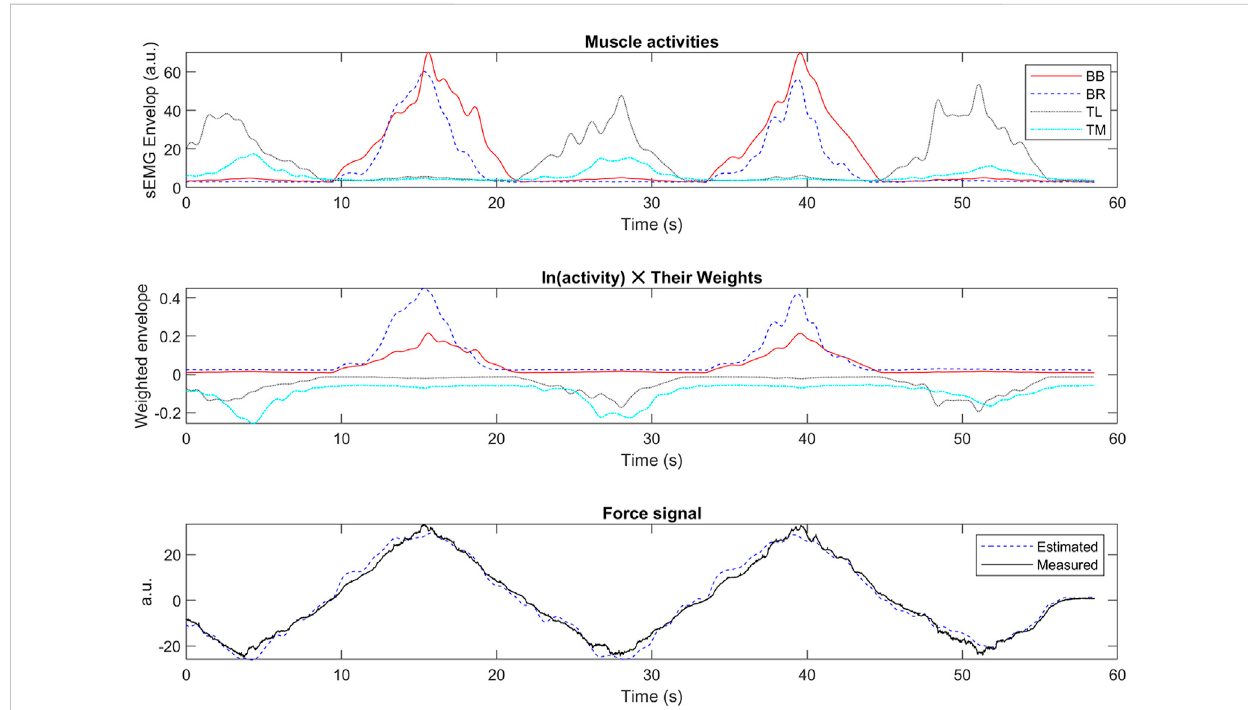
FIGURE 9 The envelope of the sEMG signal (top), the weighted activity of each muscle estimated from Eq. 7 (middle), and the estimated v.s. measured force signals (bottom) in sample data from the upper-limb test dataset (50% hold-out validation). The y-label data has a normalized arbitrary unit